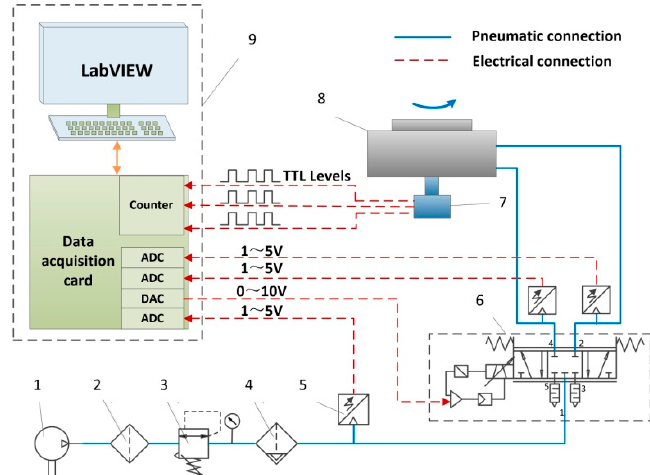
Figure 1. Schematic diagram of the pneumatic rotary actuator position servo system (1—air